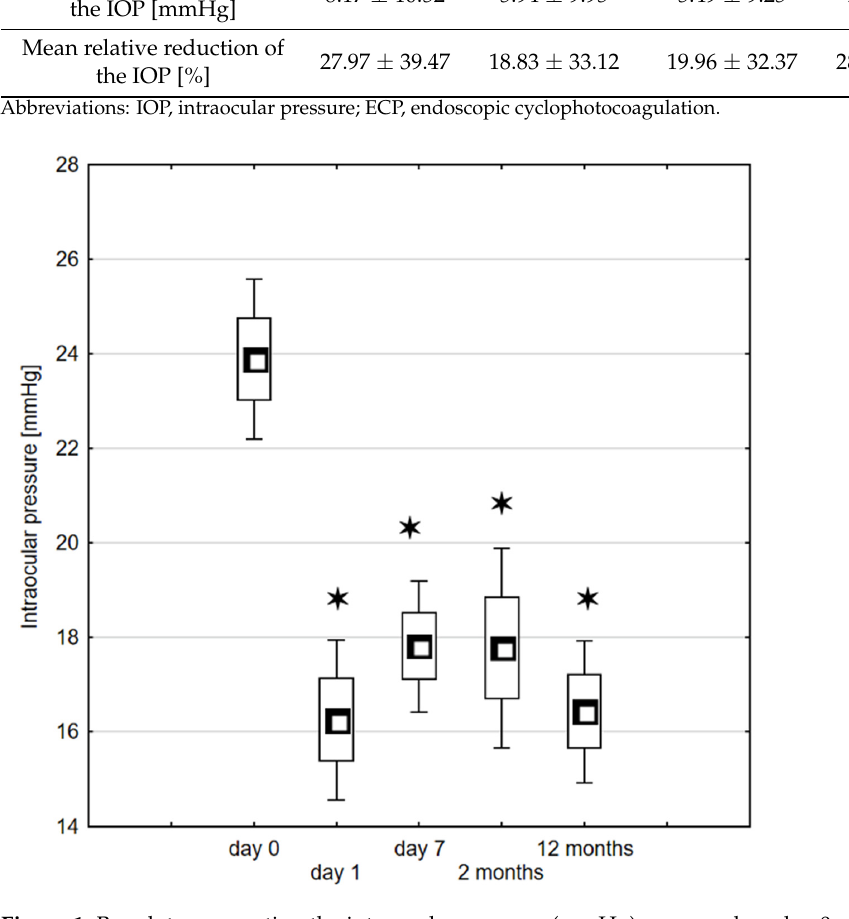
Table 2. Mean values of absolute and relative postoperative reduction of IOP depending on the time after endoscopic cyclophotocoagulation.